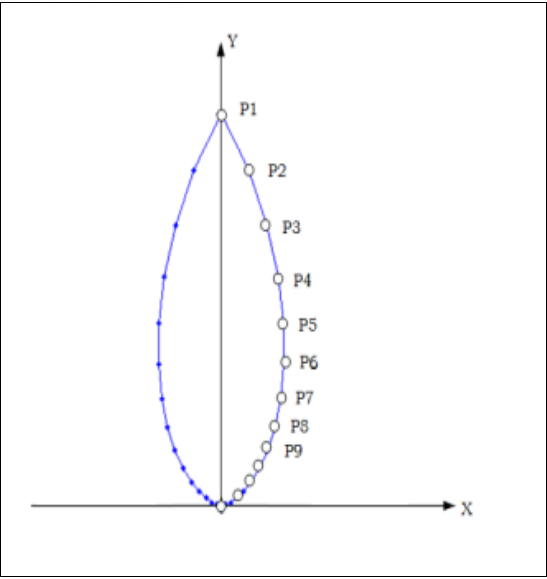
Figure 5. Isorisk index line.